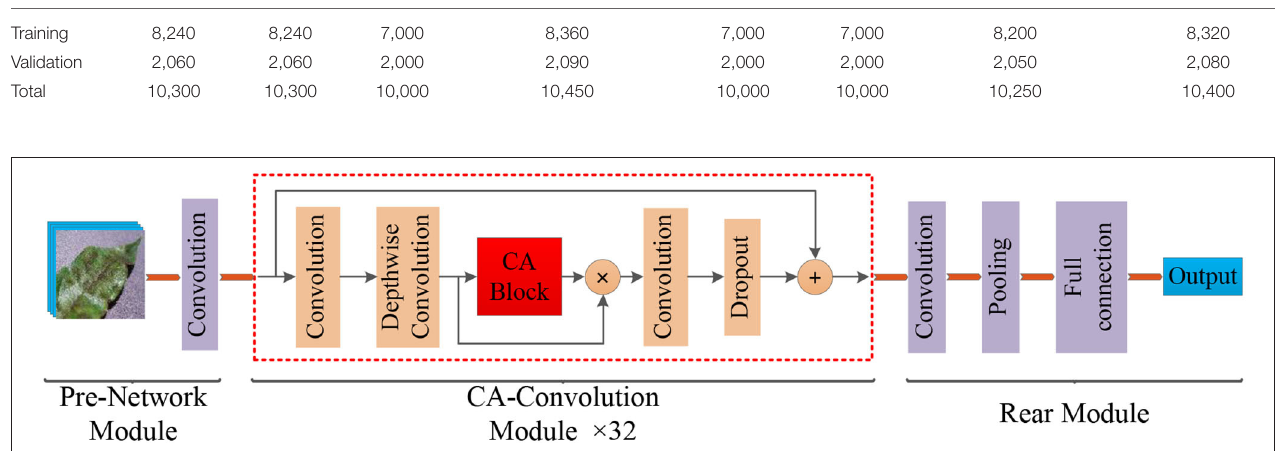
of the output feature matrix of 48 is obtained. Then, the obtained feature matrix are input into the 32 CA-Conv module embedded with the CA block. Finally, the 3 × 3 ordinary convolutions and pooling are used to further abstract features and then output through a fully connected layer with eight